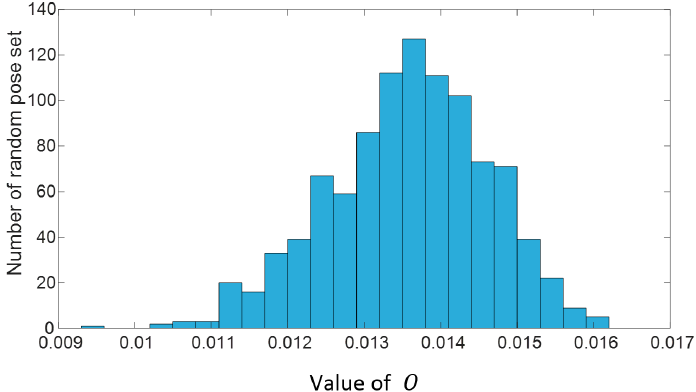
Figure 6. The process of searching for 20 optimal poses. Figure 6. Result of the observability index related to 1000 random